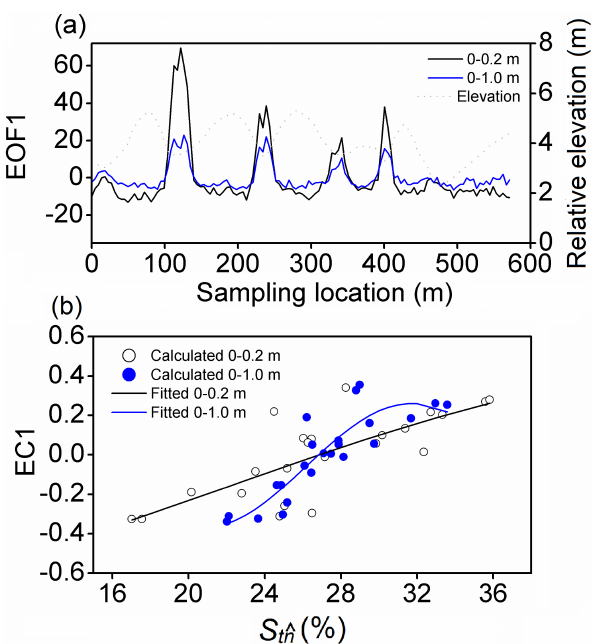
Figure 6. (a) The EOF1 of the space-variant temporal anomaly R tn and (b) relationships of associated EC1 versus spatial mean soil wa- ter content S t ˆ n fitted by the cosine function (Eq.